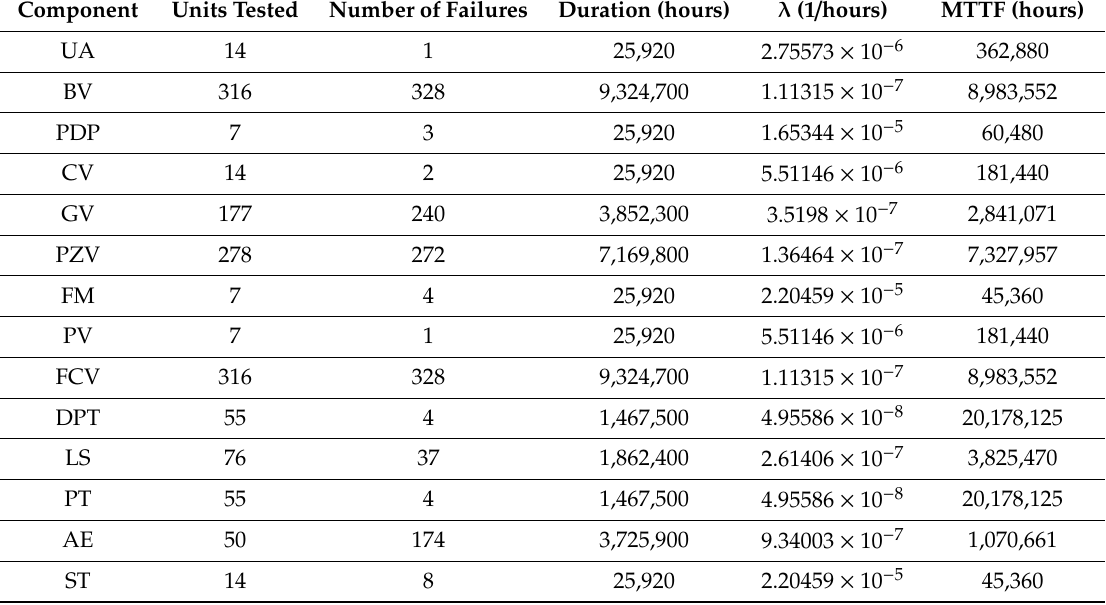
Table 3. Unloading system component test details and